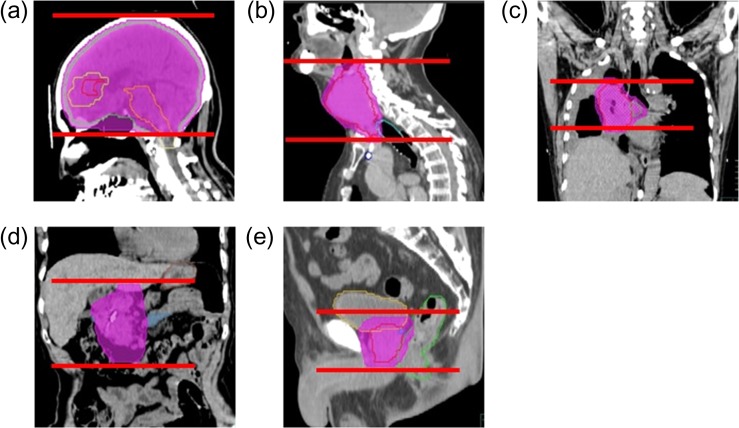
CT images and scan areas of five clinical cases for evaluating the organ dose from MVCT delivery: (a) brain, (b) head and neck, (c) lung, (d) abdomen (pancreas) and (e) prostate. The scan areas are from the superior edge to the inferior edge of the planning target volume (PTV, magenta area).